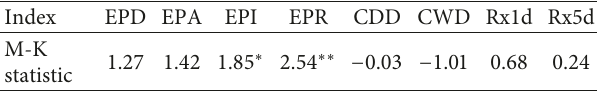
Figure 2: Variation of (a) EPD, (b) EPA, (c) EPI, and (d) EPR in Poyang Lake basin during 1960–2012. Table 3: Results of M-K test for 8 extreme precipitation